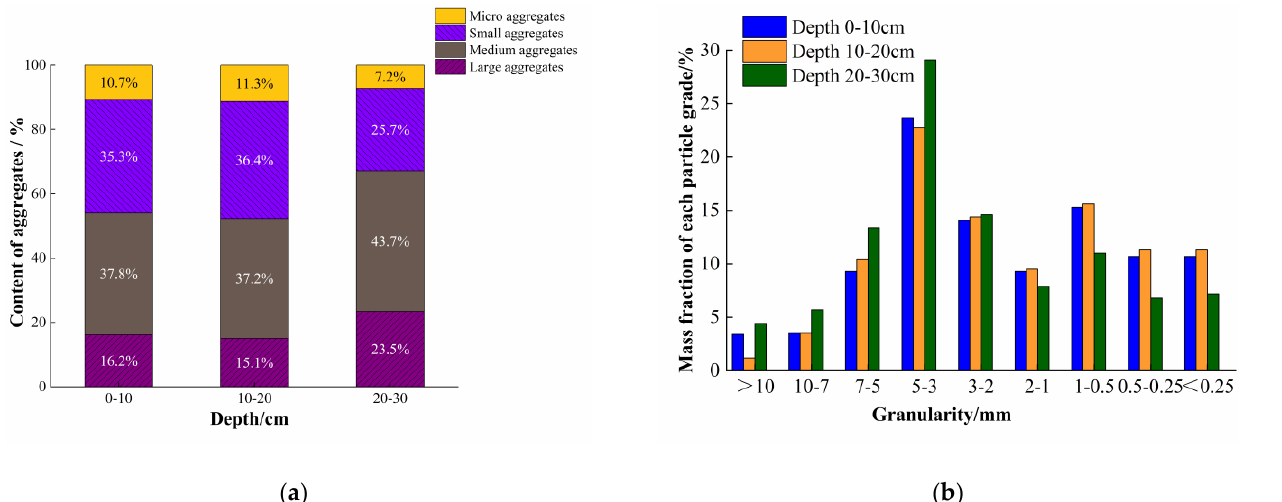
Figure 10. Distribution characteristics of aggregates. ( a ) Effect of depth on aggregates’ content; ( b ) effect of depth on the particle size of aggregates.